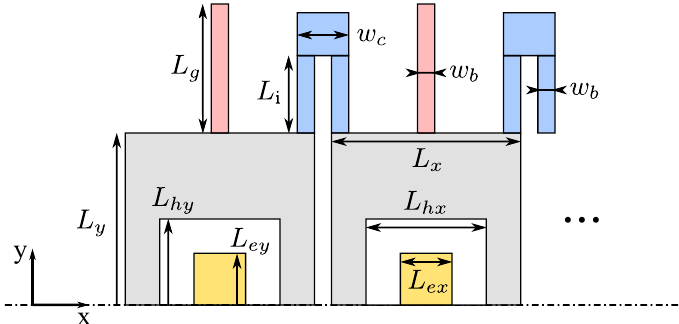
Figure 5. Scheme of the geometry of the COMSOL model (only 2 sub-cells are shown). The dashed- dotted line denotes a symmetry